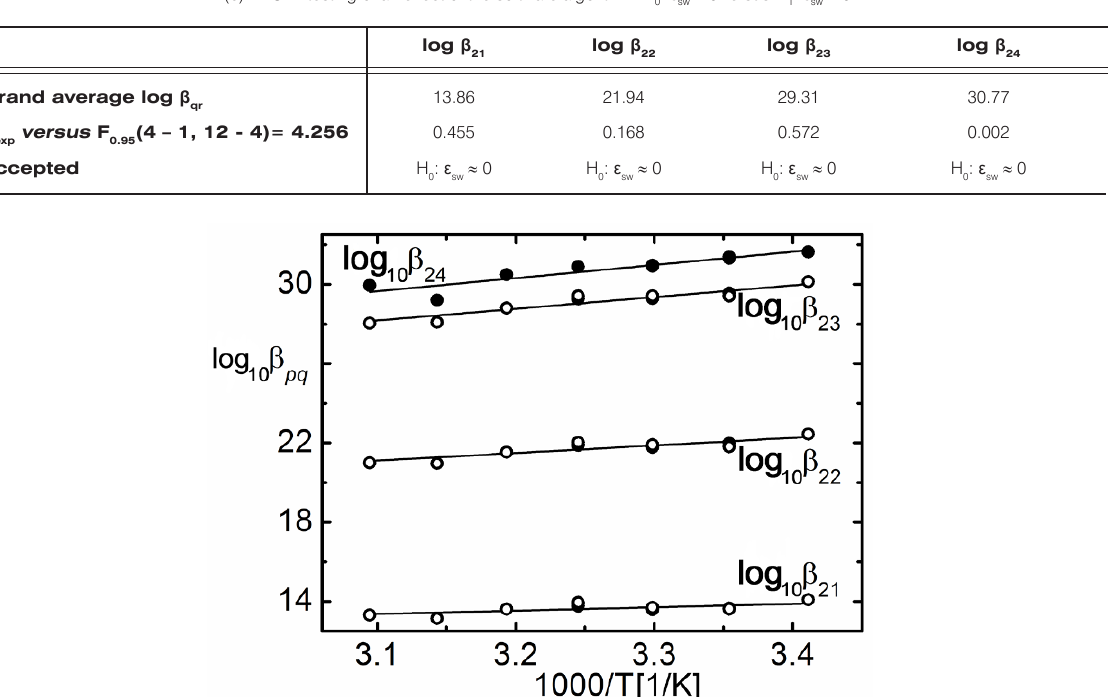
Figure 5. Dependence of protonation constants of four dimers log and L H without monomers were found (Fig. 4). In 2 the regression analysis pH was used as a dependent variable. In contrast, the differences between titrations are significant as calculated by the F -test. Analysis of